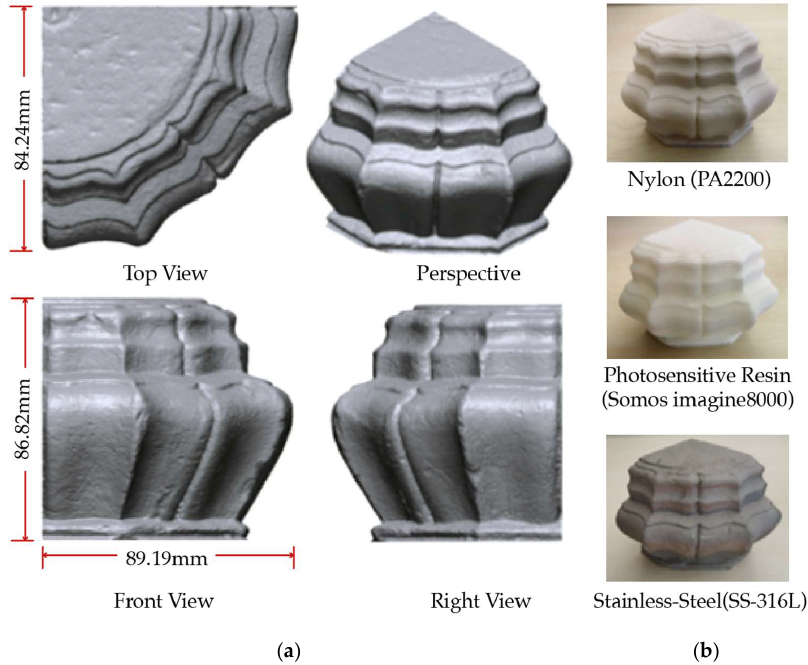
Figure 4. ( a ) Design model of stone plinth cultural innovation products; ( b ) 3D printing experi- mental